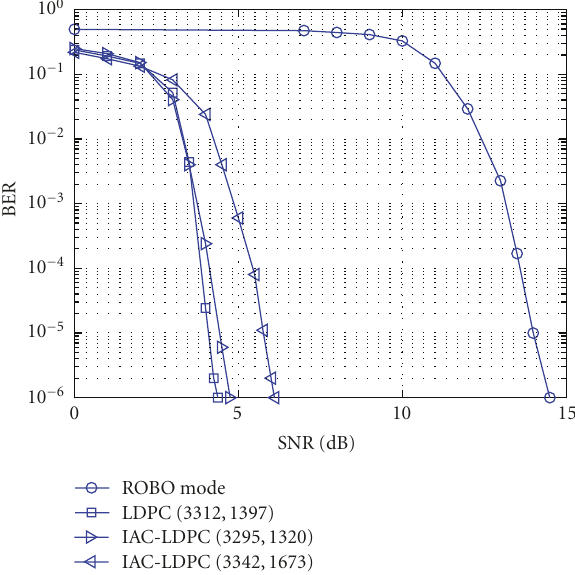
Figure 11: BER versus SNR for various LDPC coded systems and ROBO mode over a channel with both AWCN ( A = 0 . 1, GIR = 0 . 1) and multipath